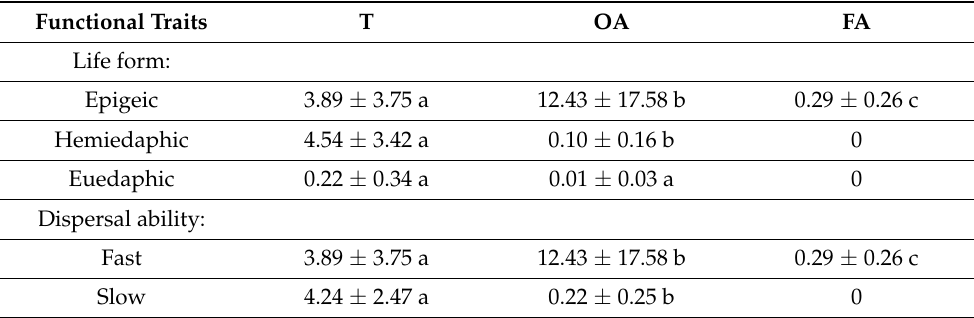
Table 4. Functional trait values in Collembola communities across seashore habitats of the Barents Sea tested by Kruskal–Wallis one-way ANOVA test. Values are means ± standard deviation (SD) across replicates ( N = 6). Significant differences are marked by different letters in rows; statistical significance tested by a multiple comparison post hoc test of mean ranks (Dunn’s test) applied after Kruskal–Wallis ANOVA with p < 0.05. T: coastal tundra, O: old algae (decaying macroalgae debris), FA: fresh algae (alive macroalgae).